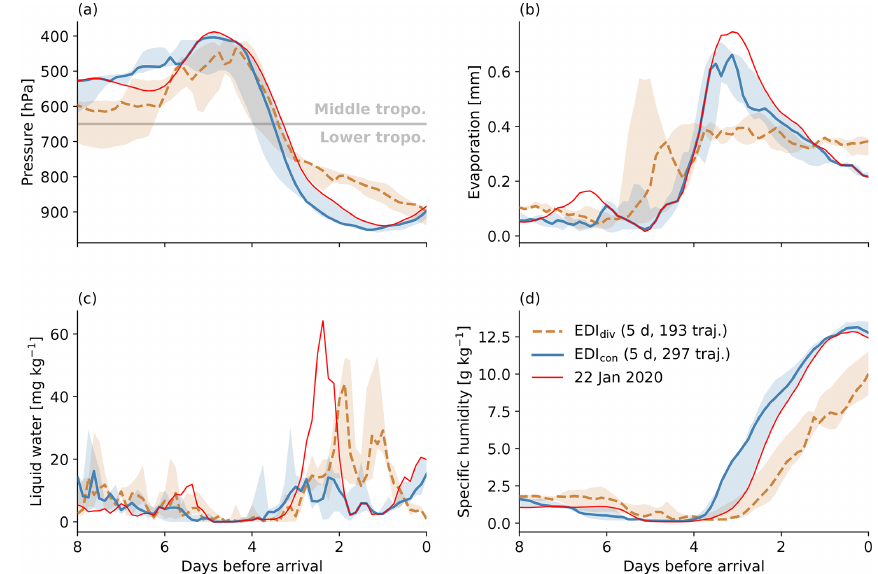
Figure 10. Time series along the EDI trajectories arriving at the BCO in the layer 1000–650hPa during the quasi-climatological period. The variables shown are (a) pressure, (b) surface evaporation, (c) liquid water content, and (d) specific humidity. The thick lines show the mean and the shadings the 25th–75th percentile range of the trajectories from the 5 EDI days with the strongest convergence/divergence (continuous blue/dashed brown lines). The mean of the EDI trajectories arriving on 22 January 2020 is shown as a thin red line. Data: